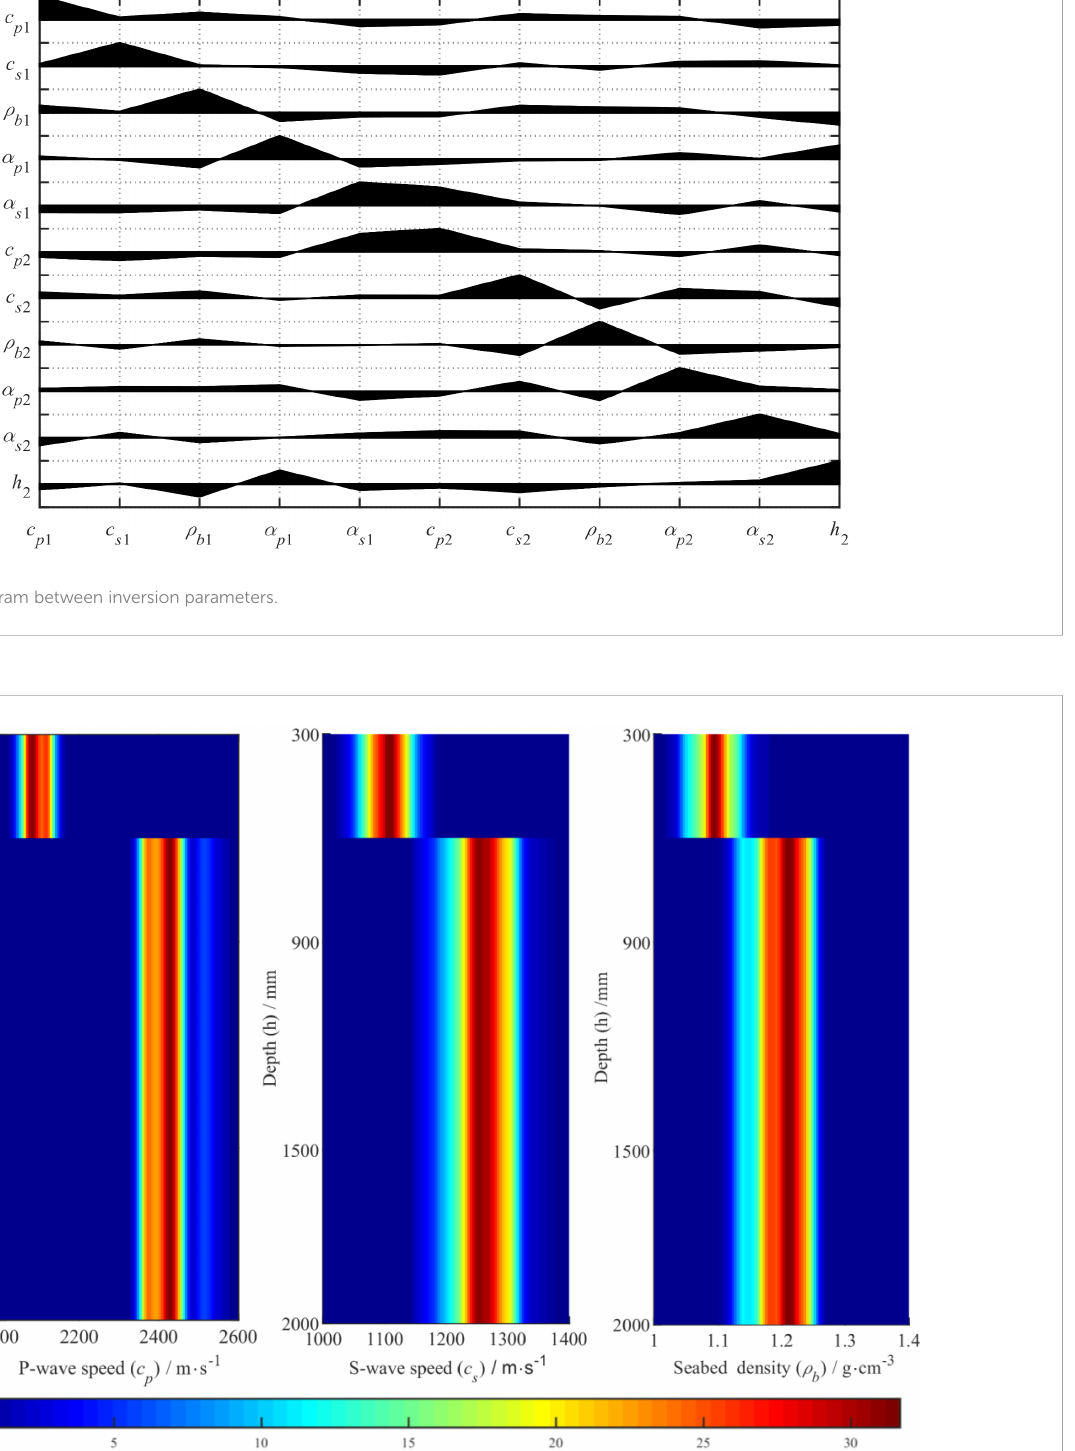
(1) Bayesian inversion of the pressure fi eld of sound can be used to obtain the parameters that de fi ne the seabed. The optimal